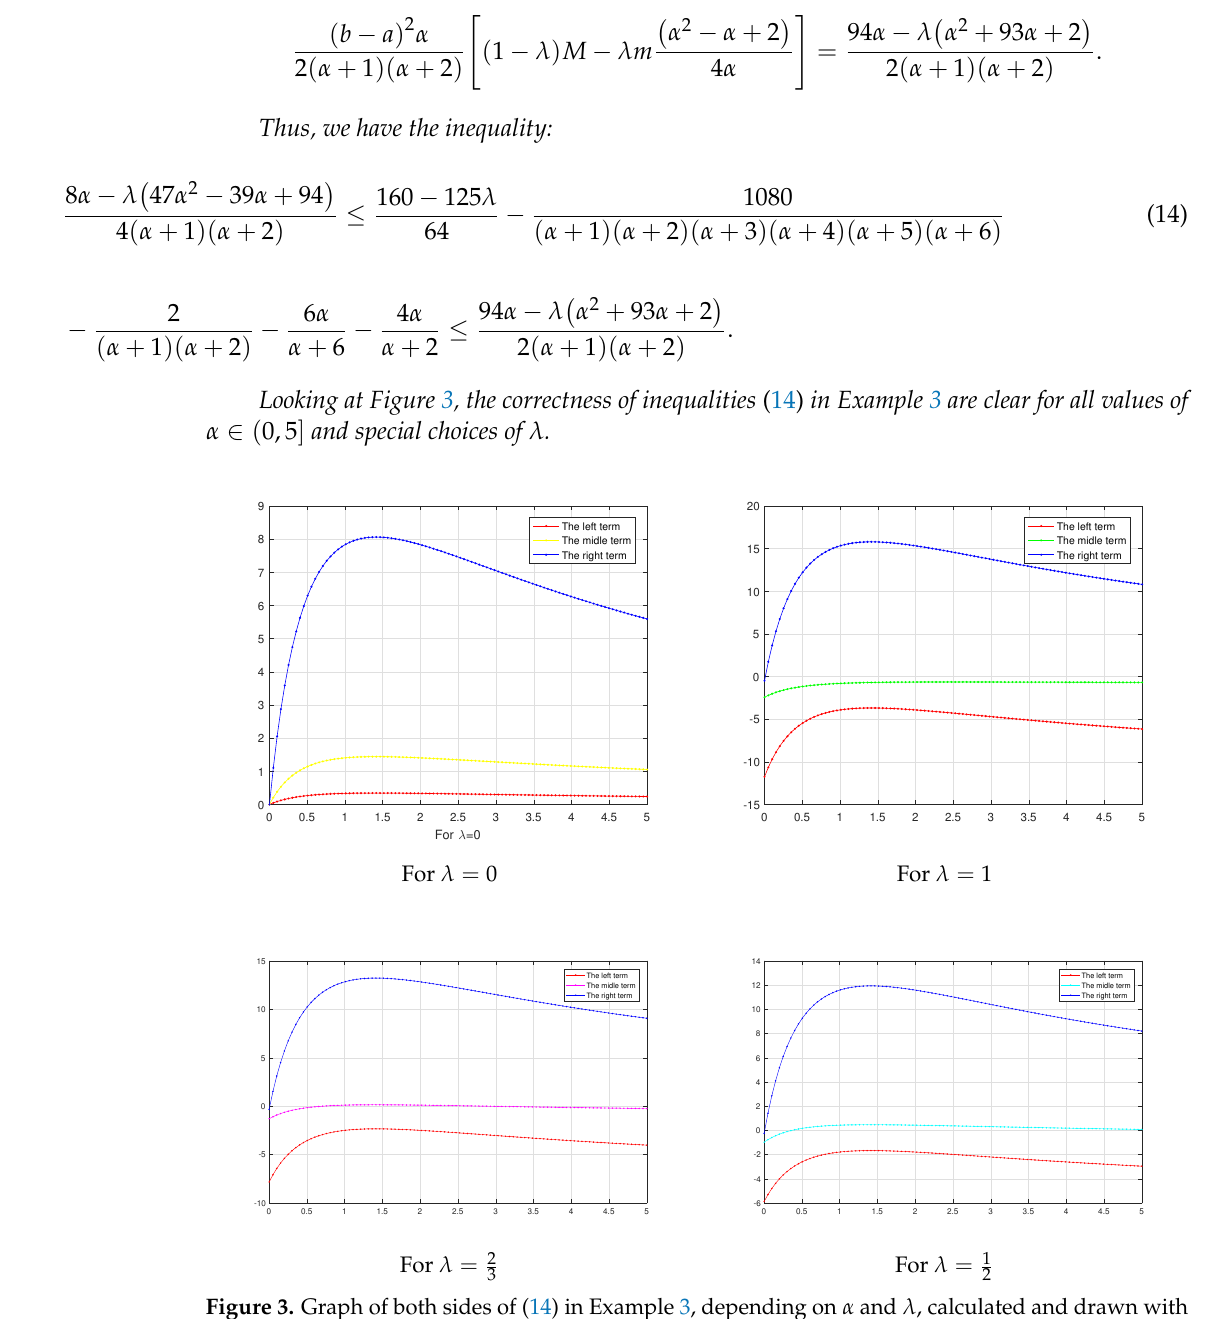
Figure 3. Graph of both sides of (14) in Example 3, depending on α and λ , calculated and drawn with